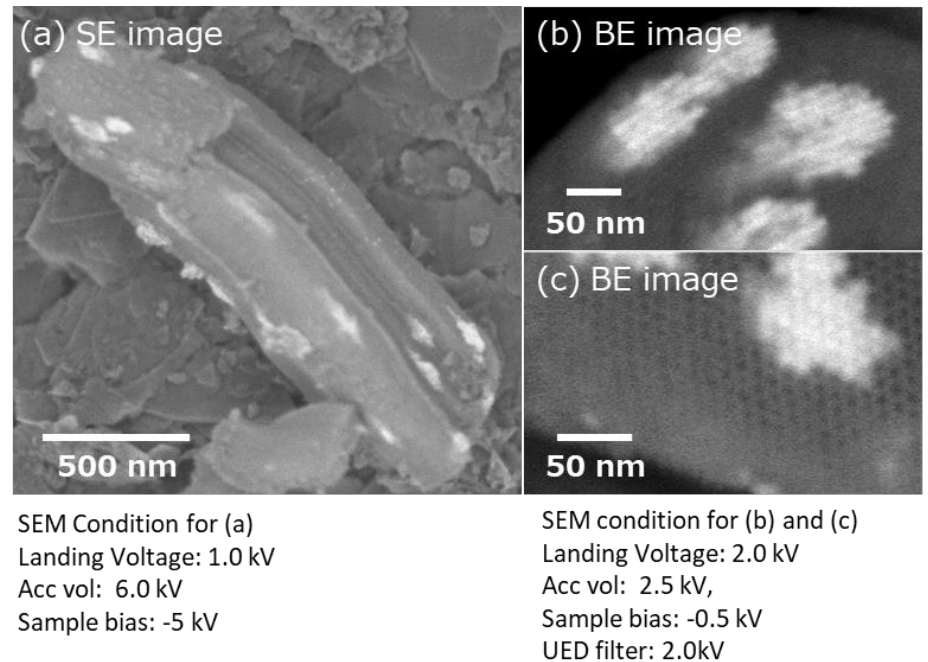
Figure 5. SEM images of mesoporous silica SBA-15 embedded with nano-casted CeO 2 . ( a ) Surface image of mesoporous silica SBA-15 which has been nano-casted with CeO 2 . ( b ) Cross section of longitudinal direction for CeO 2 in meso pores. ( c ) Cross section of CeO 2 in meso pores. The simulation results of the electron penetration depth in 50 nm CeO 2 nanocrystals are also shown in Figure 7. The penetration depth of electrons with a landing voltage of 1.5 kV is less than 50 nm. This indicates that even for the EDS analysis, the low-voltage technique can also promote the selective acquisition of surface